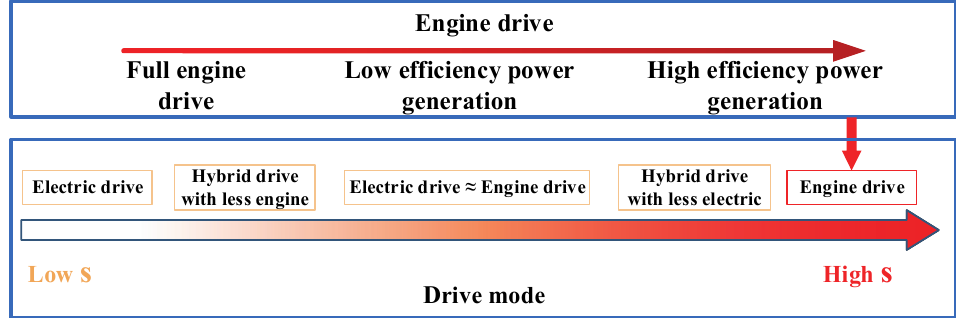
Figure 6. Equivalent factorial design logic.